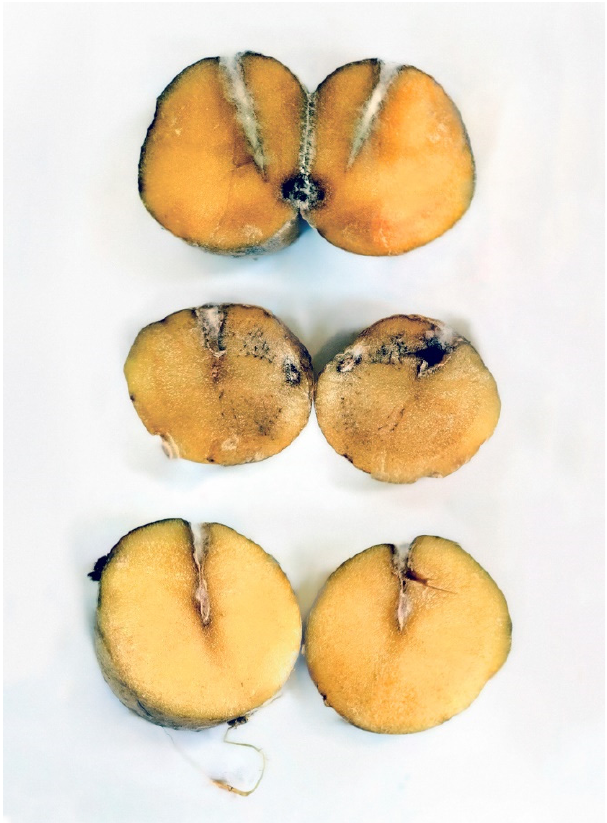
Figure 2. Cross-section of potato tubers infected with Thichocladium solani strains from top to bottom: VKM F-4904, VKM F-4902, and VKM F-4913 after 7 days at 25 ◦